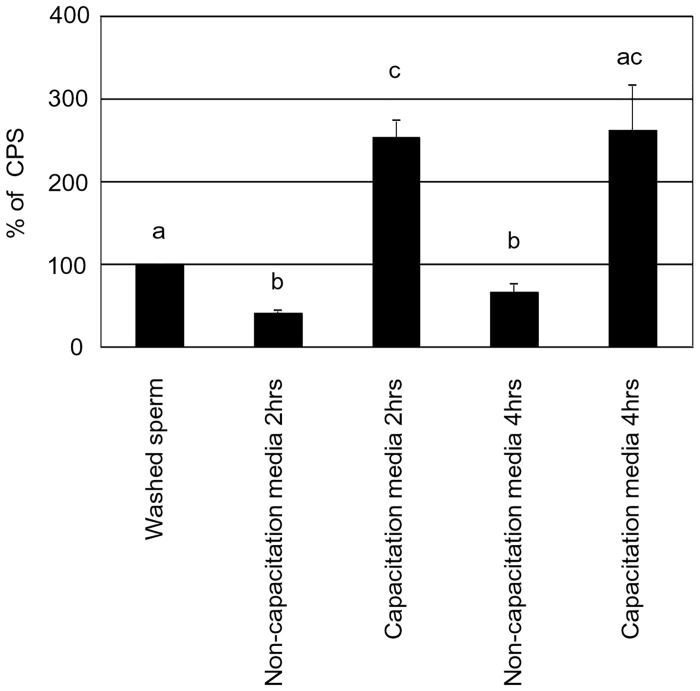
ROS production of one individual motile sperm in non-capacitation media and capacitation media.Different letters within columns indicate significant differences as determined by one-way ANOVA with Tukey-Kramer analysis (P<0.01). This experiment was repeated 3–4 times. Statistical significance compared to control: a vs b vs c.